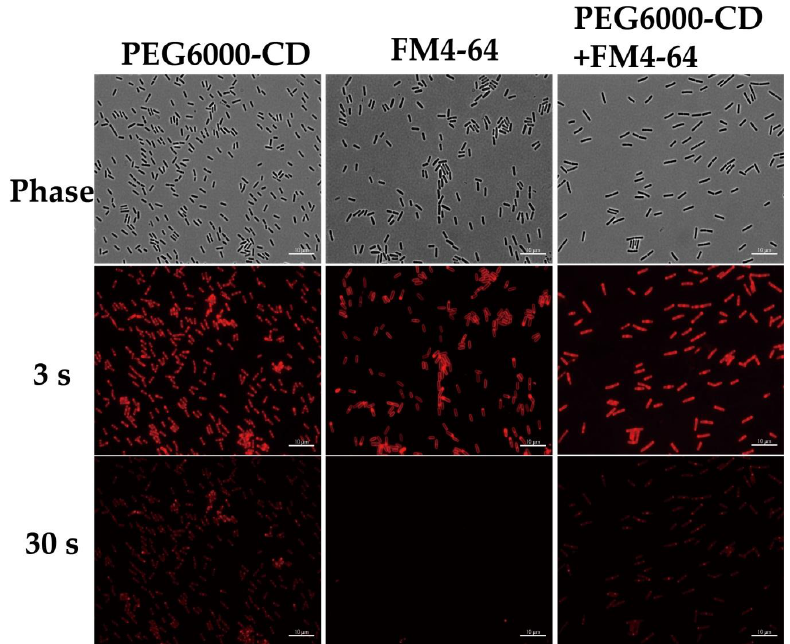
Figure 9. Fluorescence microscopy images of B. subtilis stained with PEG 6000 /CDs and FM4-64 membrane dye and excited with t 490 nm wavelength for two different durations (3 s and 30 s) before imaging. Cells were stained with PEG 6000 /CDs at 100 ppm. Control cells were assayed similarly without adding PEG 6000 /CDs. TRITC filter detected red color. Scale bar represents 10 μm.